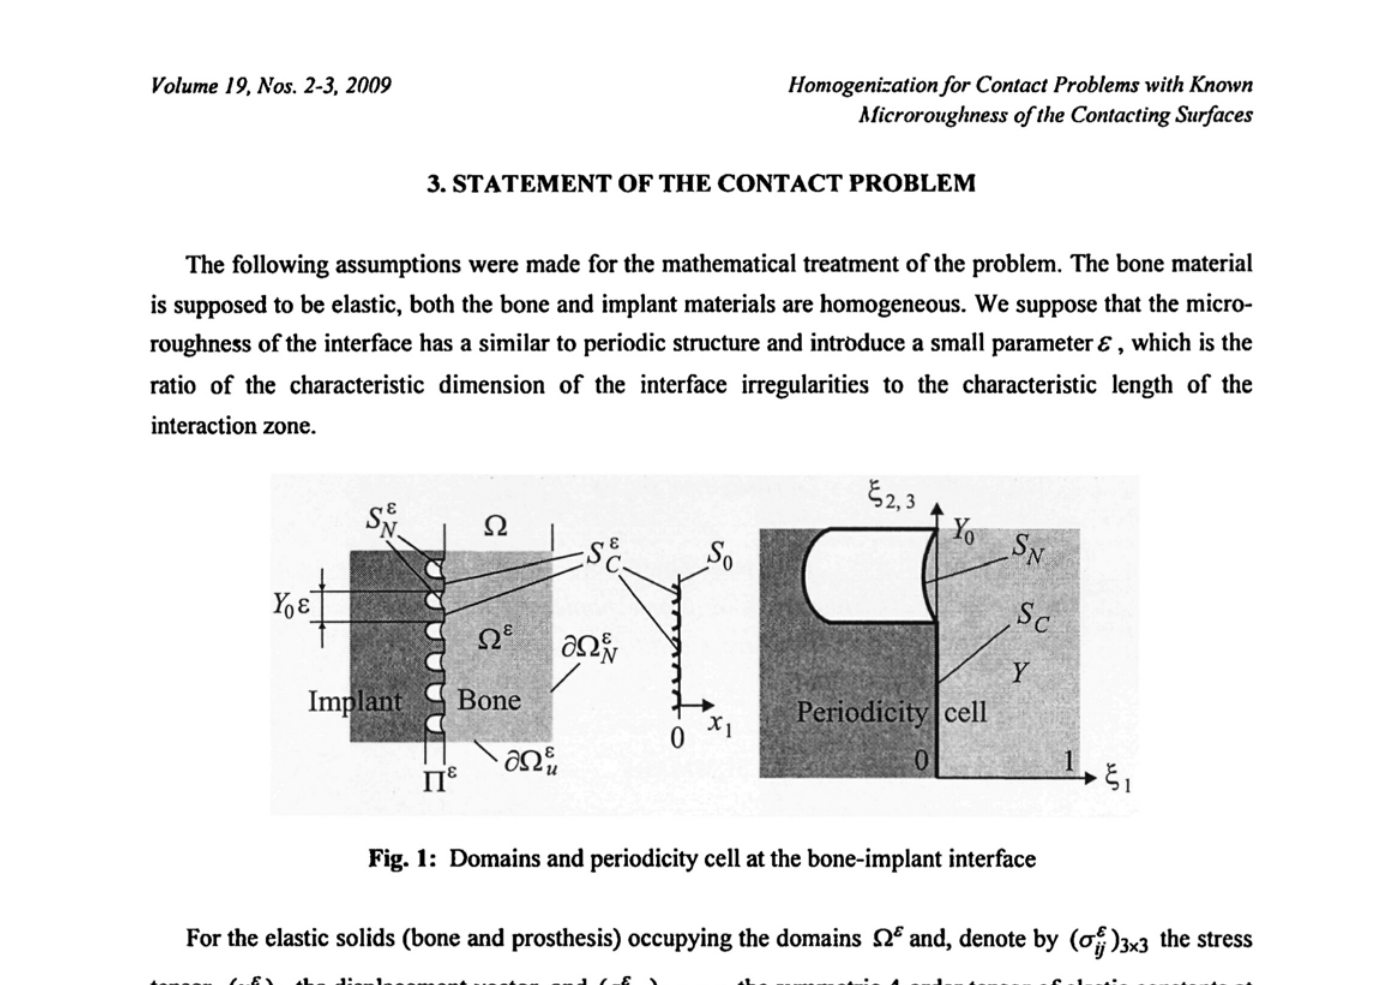
Fig. 1: Domains and periodicity cell at the bone-implant